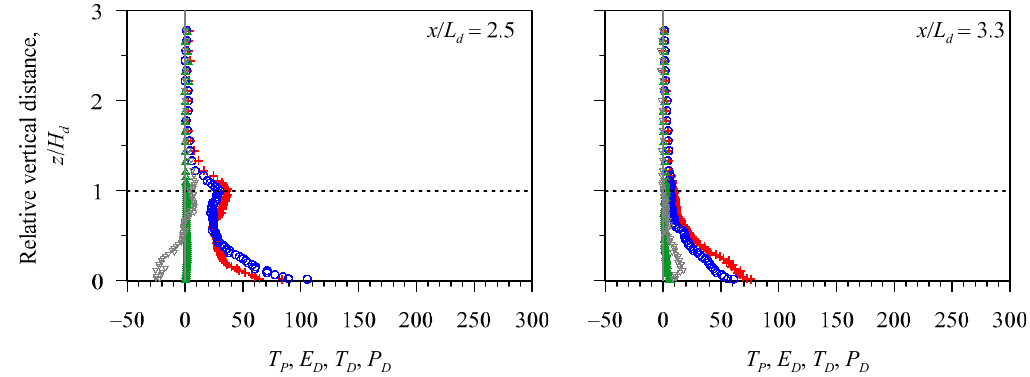
Figure 13. Vertical profiles of the nondimensional components of turbulent kinetic energy budget T P , E D , T D and P D at various relative streamwise distances x / L d in Run 1.